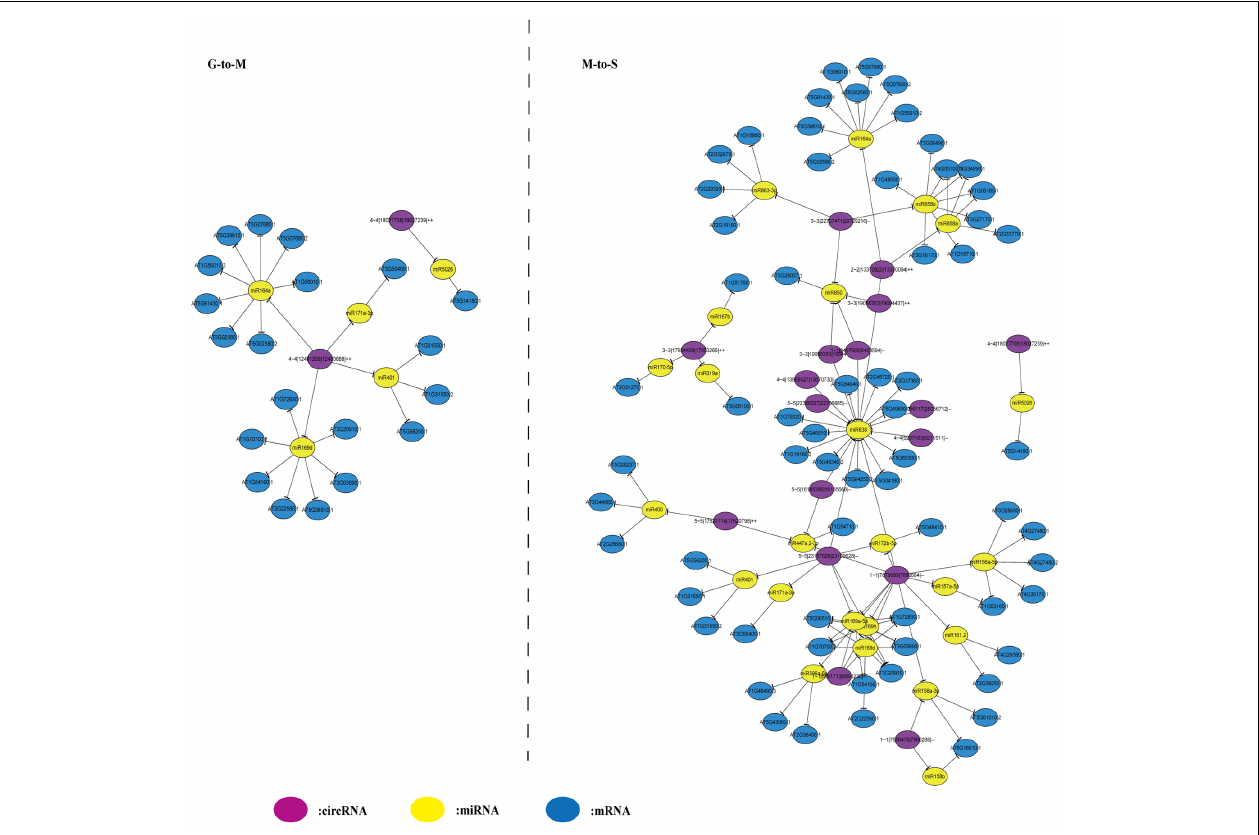
FIGURE 3 | The circRNA-microRNA-mRNA network at G- to -M and M- to -S. The circRNA-microRNA-mRNA network at G- to -M consists of 20 pairs. The circRNA-microRNA-mRNA network at M- to -S consists of 220